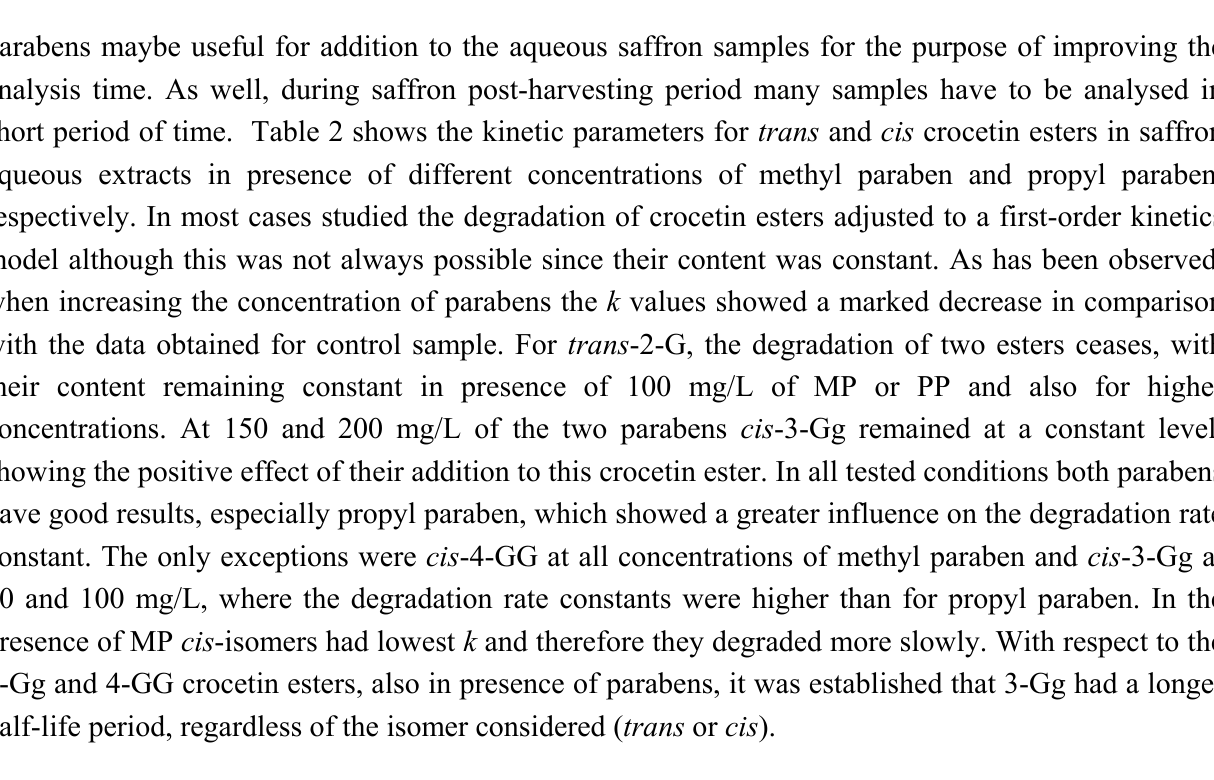
Table 2 . Degradation rate constant (k), determination coefficient (R 2 ) and half-life period (t ) of overall, trans , cis and individual crocetin esters in saffron aqueous extract in 1/2 presence of methylparaben and propylparaben, respectively, at 25